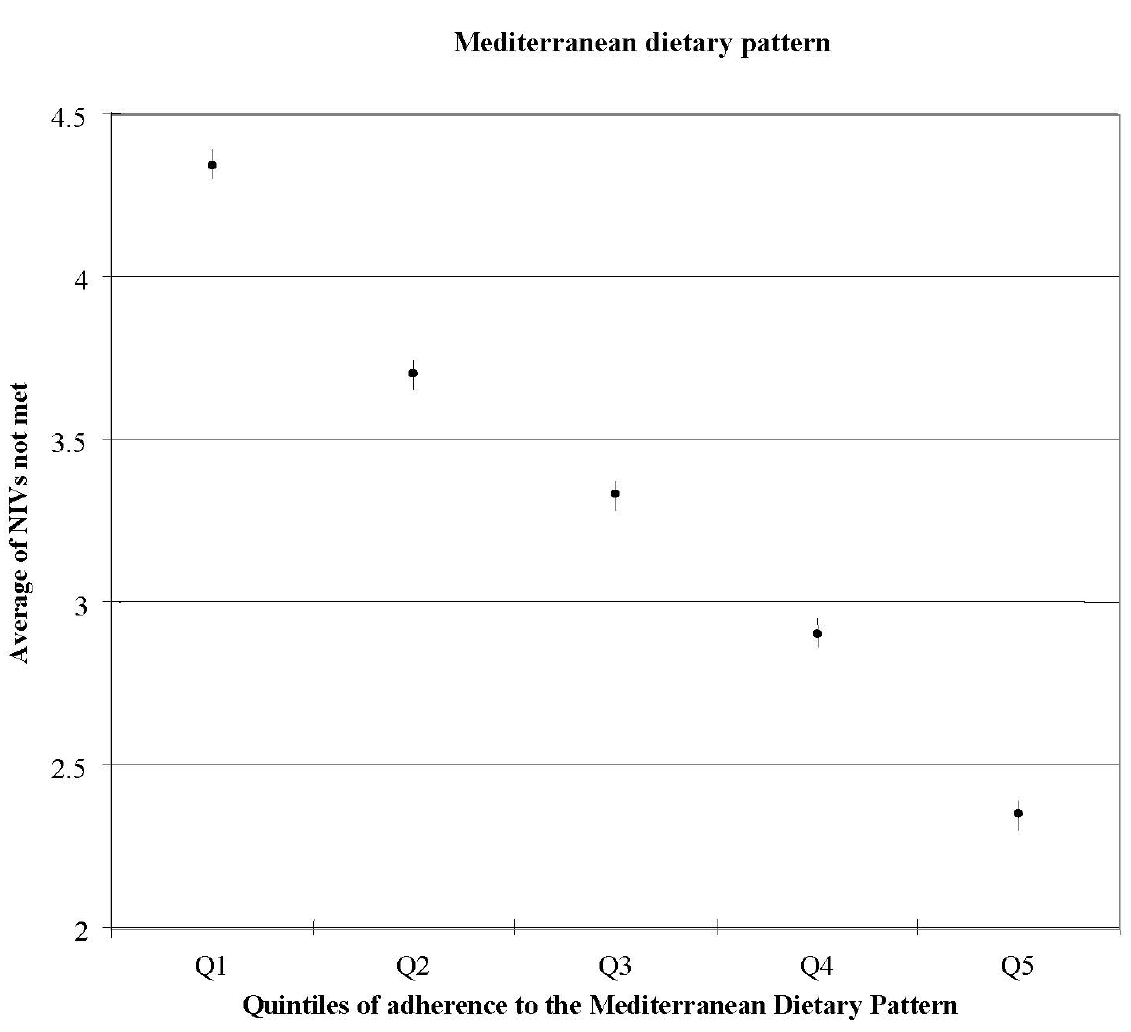
Figure 3. Average number of nutrients with intakes not meeting recommended levels across quintiles of the Mediterranean Diet pattern score; adjusted for age and sex